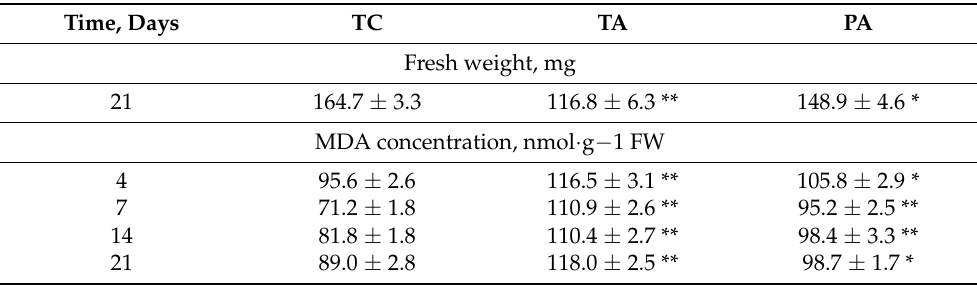
Table A1. Tobacco in vitro shoot biomass and MDA accumulation of the control (TC), timentin-treated (TA) and post-antibiotic treatment (PA) experimental groups.